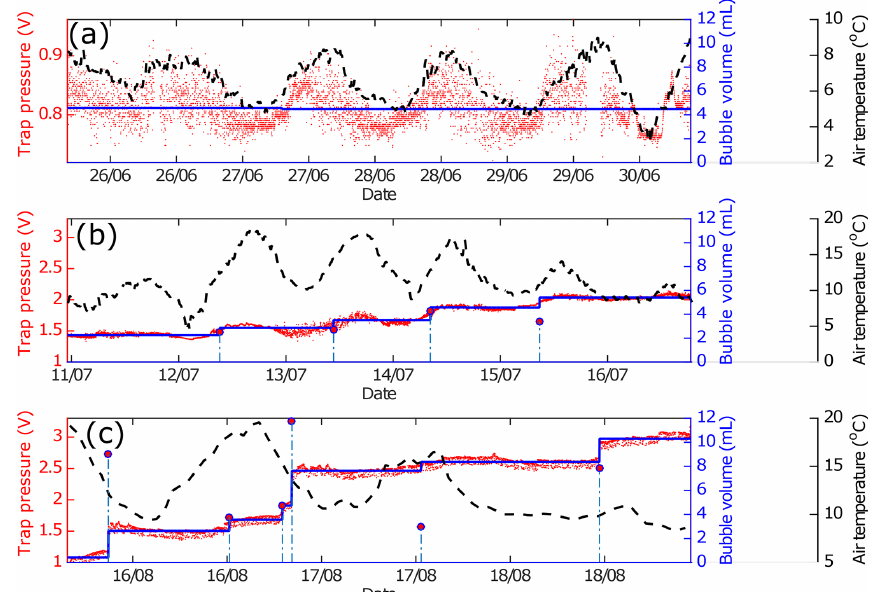
Figure 2. ABC pressure signal and air temperature over three field deployment periods. Red dots are trap pressure signals, blue lines are the denoised pressure sensor signal, stem plots (dashed vertical lines with a red circle on top) are bubble events which were detected from the stepwise increase in denoised signals, and black dashes are air temperature. (a) Sample period with no bubbles entering the trap, (b) sample period with small bubbles entering the trap, and (c) sample period with both big and small bubbles entering the